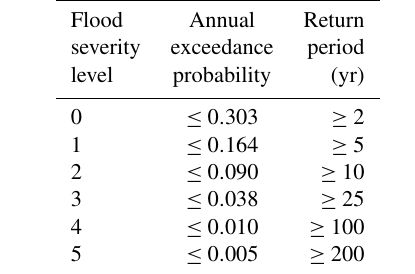
Table 2. Thresholds that were used to classify the exceedance prob- abilities according to flood severity levels.